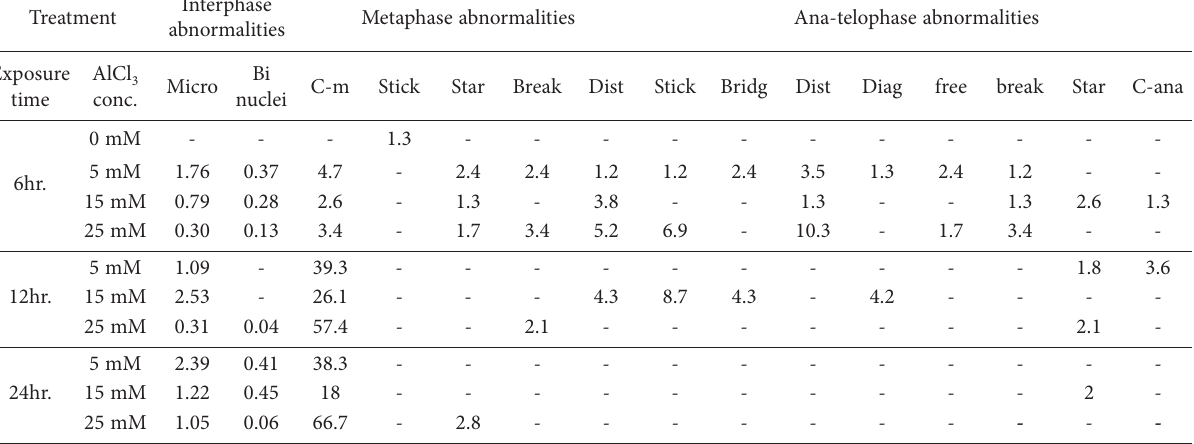
Table 3. Types and frequency of chromosomal abnormalities [C-metaphase (C-m), sticky (Stick), star, break, disturbed (Dist), and diagonal (Diag), bridge, free and C-anaphase (C-ana)] recorded for Vicia faba (Misr 3) root tips under the influence of different concentrations of AlCl 3 and exposure times (6, 12, and 24